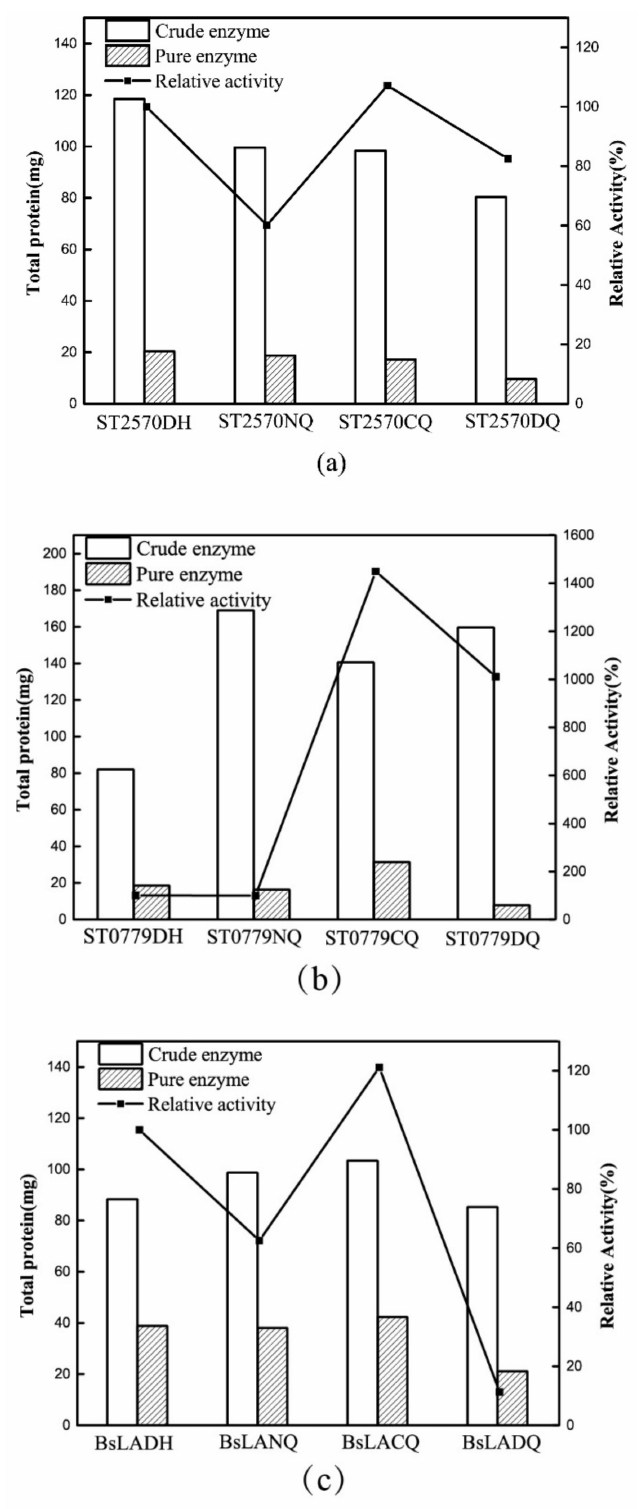
Figure 3. The expression level and activity of di ff erent enzymes. ( a ) ST2570; ( b ) ST0779; ( c ) BsLA. Relativity activity (%) is the percentage of the DH activity obtained in the series. The DH activity was defined as 100% relative